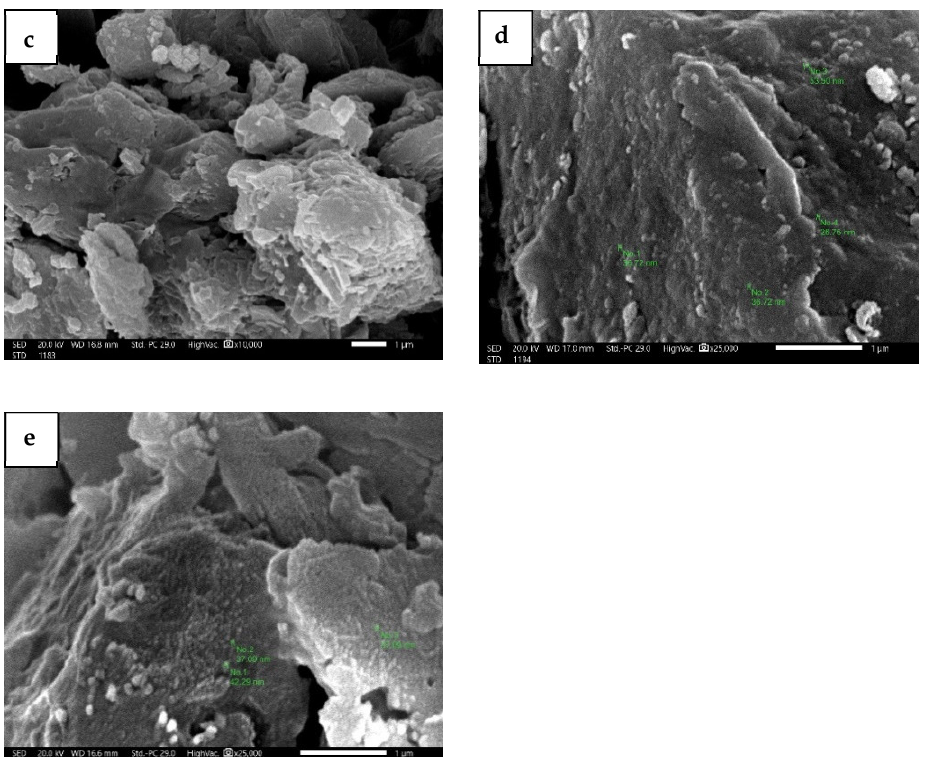
Figure 3. SEM images of the ( a ) GLM, ( b ) GLM-mPbO10, ( c ) GLM-mPbO30, ( d ) GLM-nPbO10, and ( e ) GLM-nPbO30 samples.